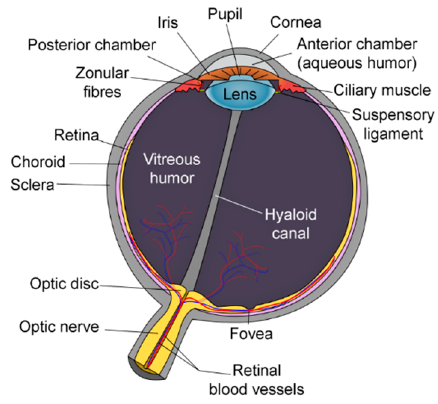
Figure 1. Human eye anatomy [3].